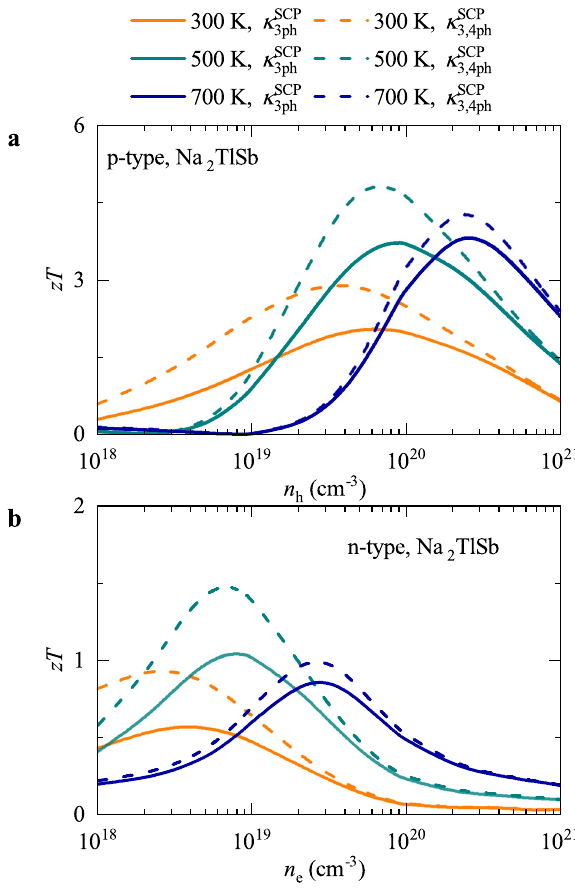
Fig. 8 TE performance. The calculated TE fi gure of merit with the κ SCP and κ SCP for a p-type and b n-type Na 2 TlSb at 300, 500, and 3ph 3 ; 4ph 700 K. The SOC is also included in the